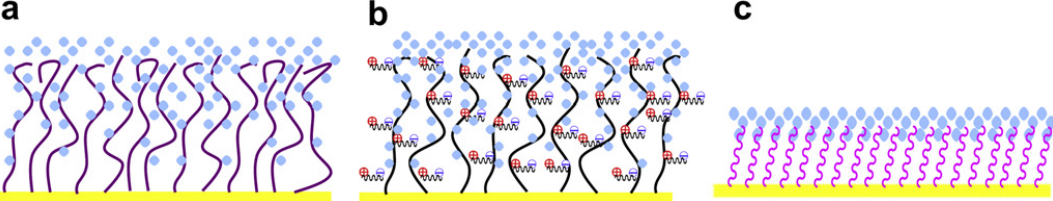
Figure 4. Illustration of chain hydration and chain flexibility of ( a ) hydrophilic polymers, ( b ) zwitterionic polymers and ( c ) SAMs, which have different attributes of surface resistance and nonspecific protein adsorption. Reproduced with permission from Chen et al. [42] (Copyright © (2010)